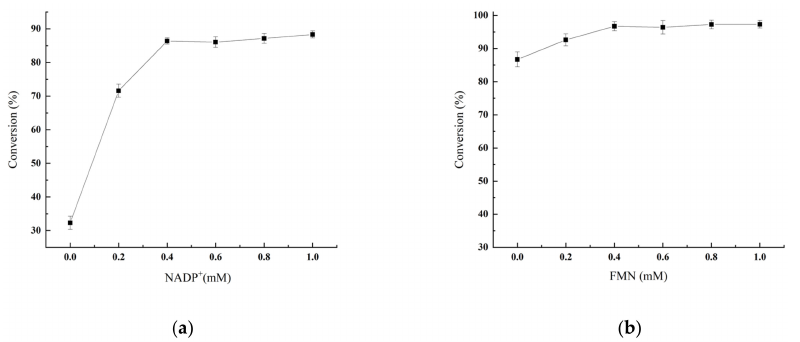
Figure 4. Effect of NADP + ( a ) and FMN ( b ) on enzymatic double reduction of ( E / Z )-citral to ( S )- citronellol. ( a ), the reaction mixture (10 mL) contained 200 mM ( E / Z )-citral, 600 mM glucose, 1 g wet cells, 0–1.0 mM NADP + , 20% ( v/v ) isopropanol, and 50 mM PIPES buffer (pH 6.5). ( b ), the reaction mixture (10 mL) contained 200 mM ( E / Z )-citral, 600 mM glucose, 1 g wet cells, 0.4 mM NADP + , 0–1.0 mM FMN, 20% ( v/v ) isopropanol and 50 mM PIPES buffer (pH 6.5). The reactions were conducted at 30 ◦ C and 400 rpm for 12 h. Standard deviations are indicated in the diagram ( n = 3).